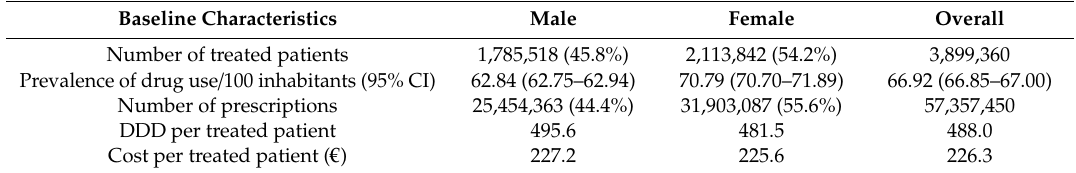
Table 1. Characteristics of the study